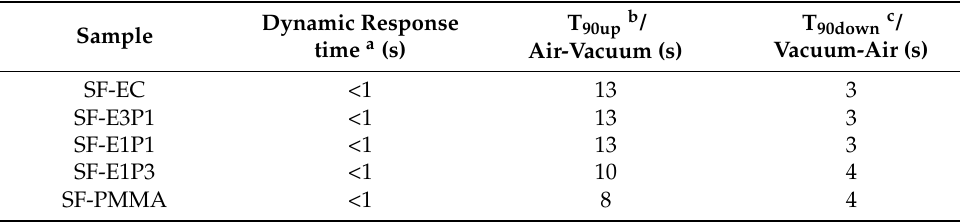
Table 1. Response time of the sensing films with different polymer matrices.